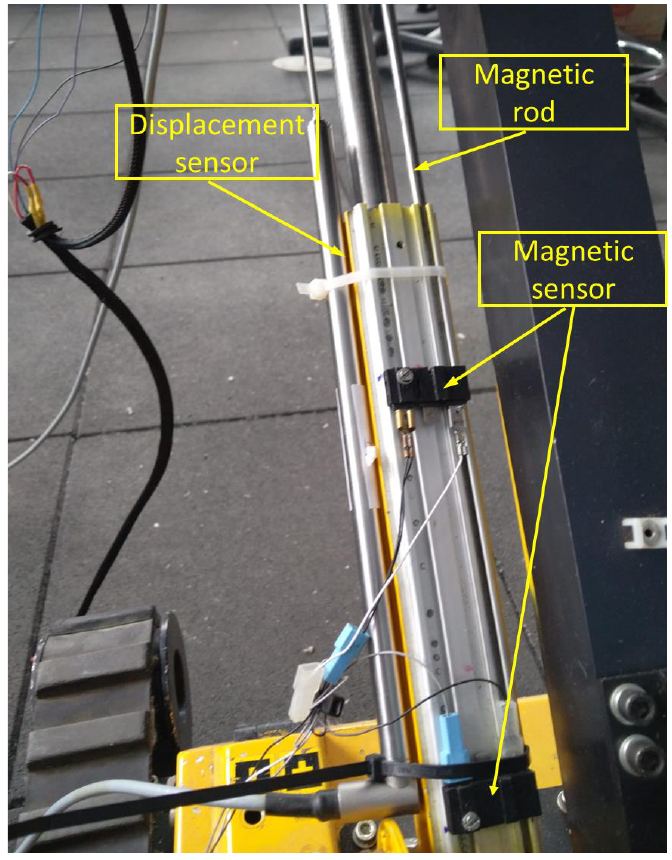
Figure 12. The robotic arm opening control system, which is composed of a magnetic rod to limit the stroke of the linear motor; it moves between the two magnetic sensors to control the stroke of the linear motor, so that the power supply of the motor can be stopped.